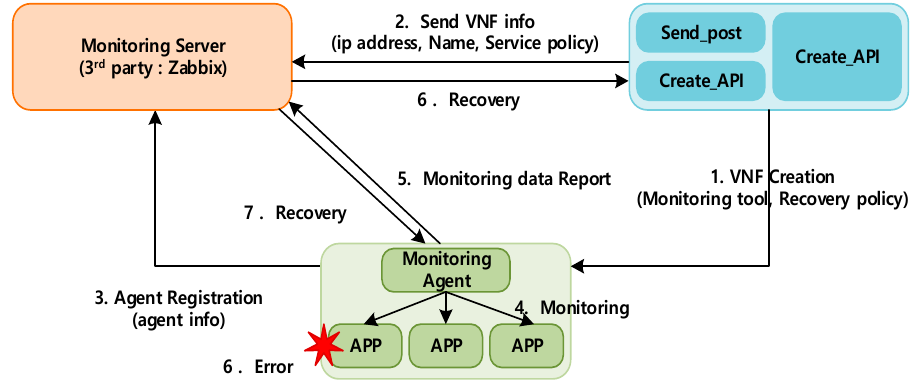
Figure 7. Procedure of service recovery for availability.